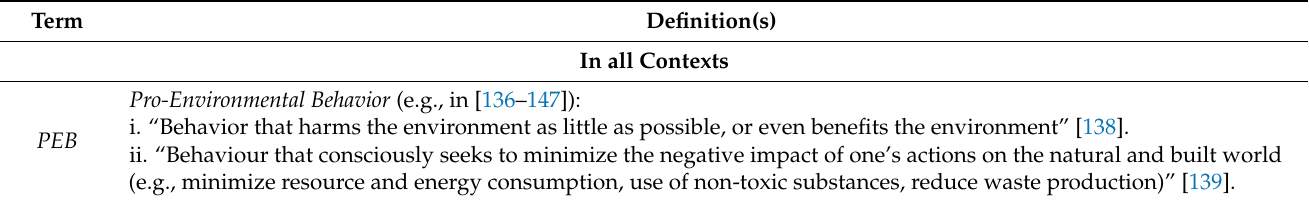
Table 6. Glossary of terms in the context of organizational energy-saving